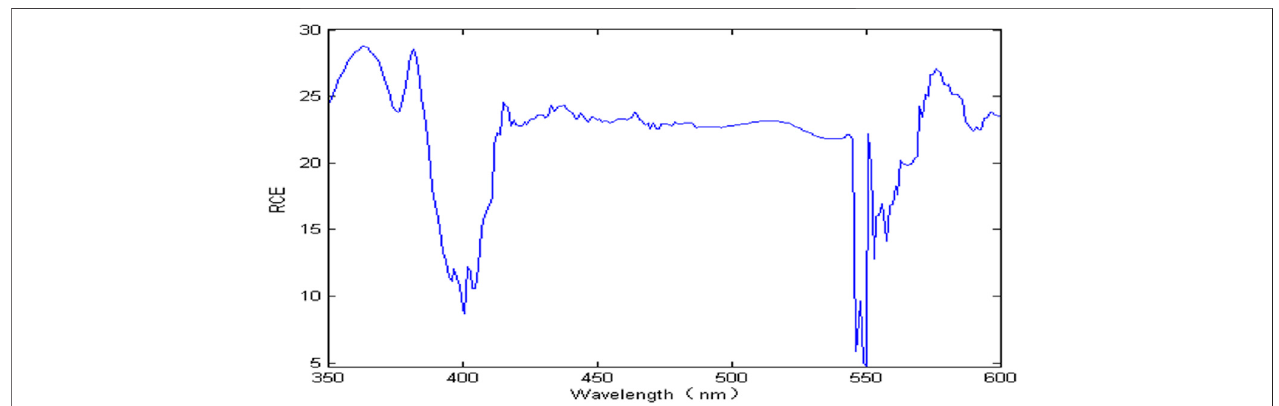
FIGURE 5 | The RCE value of nickel at different